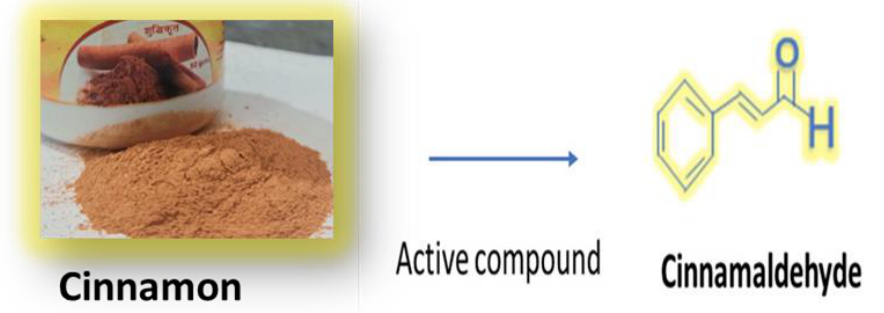
Figure 2. Active compound of cinnamon